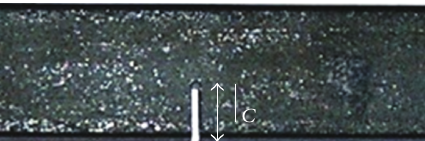
Figure 10: Numerical model and element numbering.